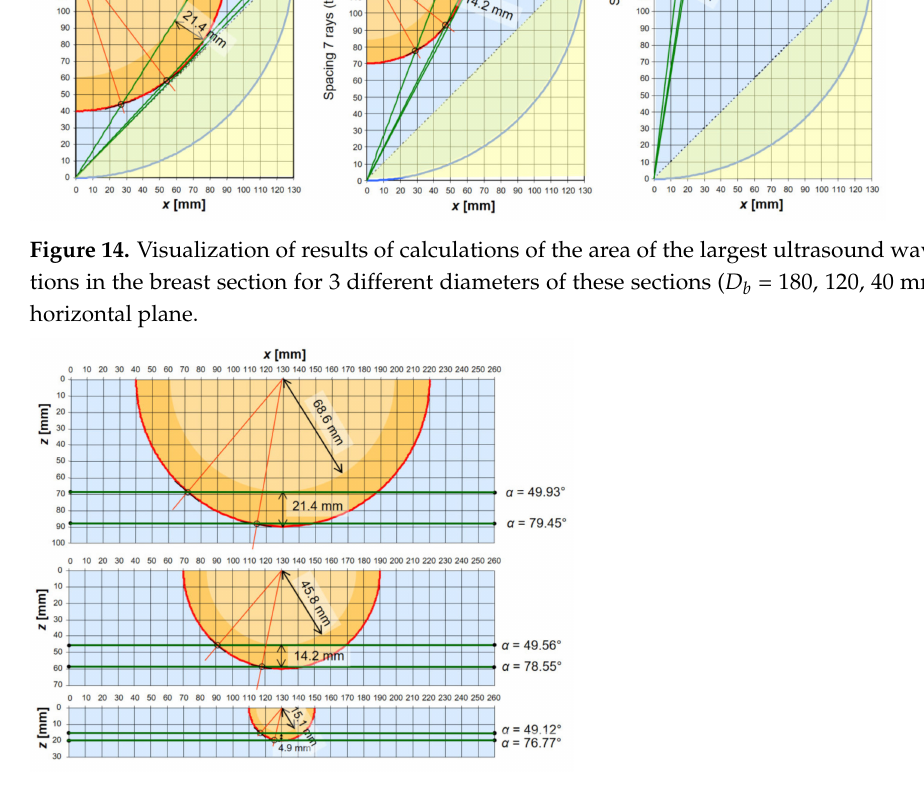
Figure 15. Visualization of results of calculations of the area of the largest refractions of the ultrasound wave in the breast section for 3 different diameters of these sections ( D b = 180, 120, 40 mm) in the vertical